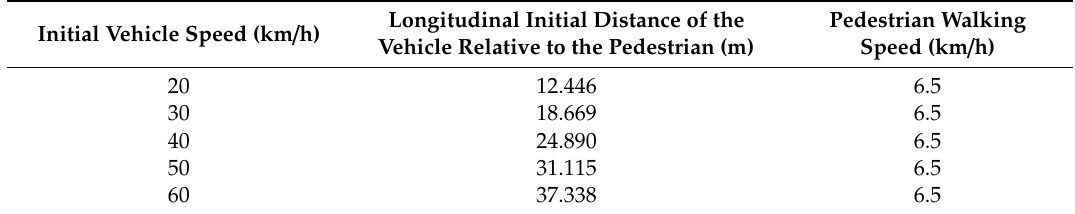
Table 10. CVFA-25 simulation